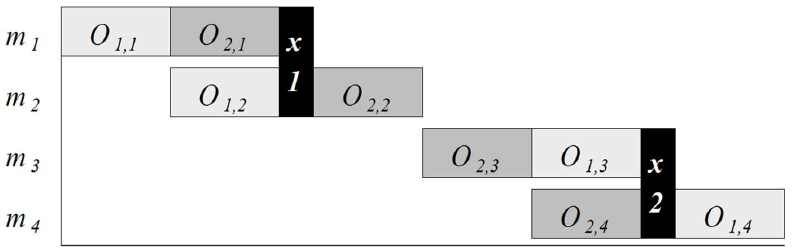
Fig. 4. Generic case of a NPFS schedule of 2 jobs ( j 1 and j 2 ) and 4